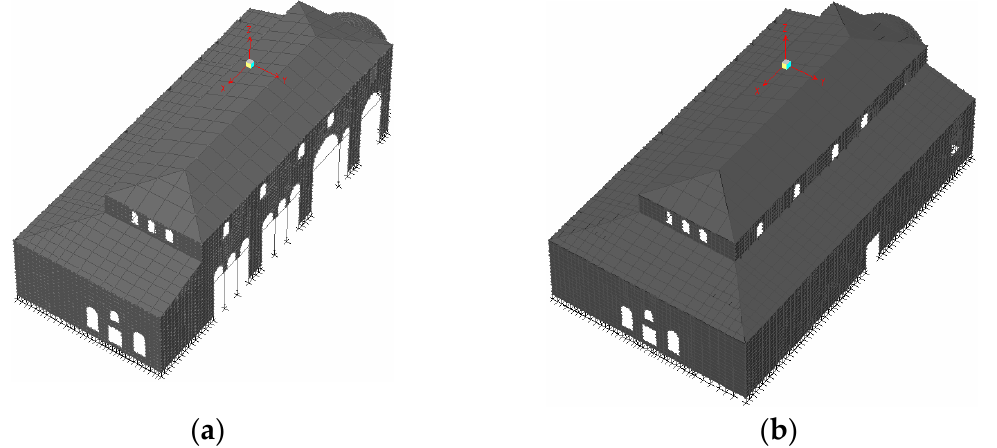
Figure 1. ( a ) The Basilica structural system with the interior colonnade of the central nave; ( b ) The Basilica structural system with the peripheral longitudinal and transverse walls.